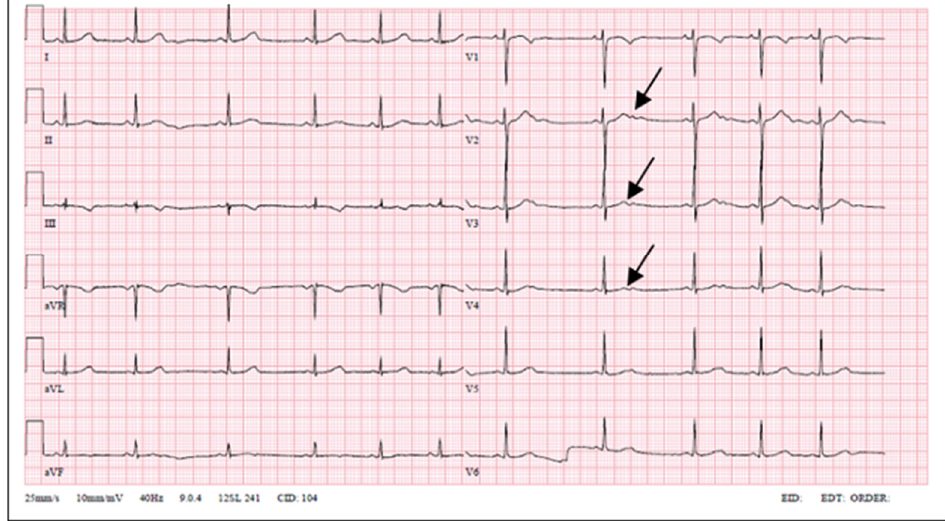
Figure 4. Patient’s daughter ECG (low-amplitude notched T waves, QTc 423 ms).